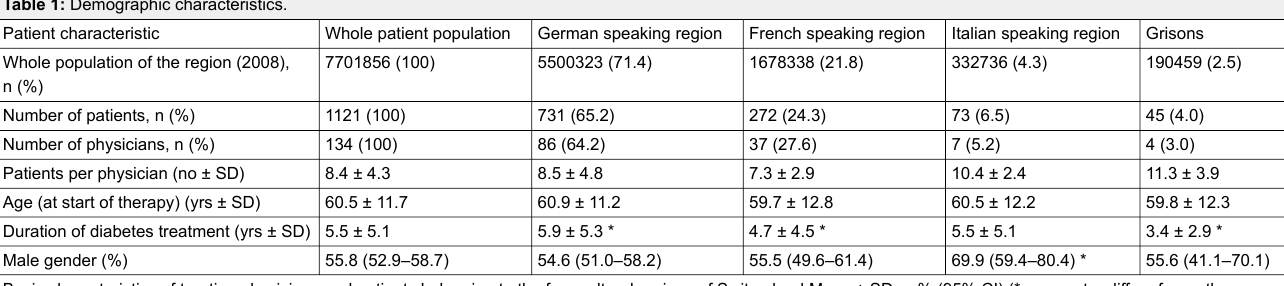
Table 1: Demographic